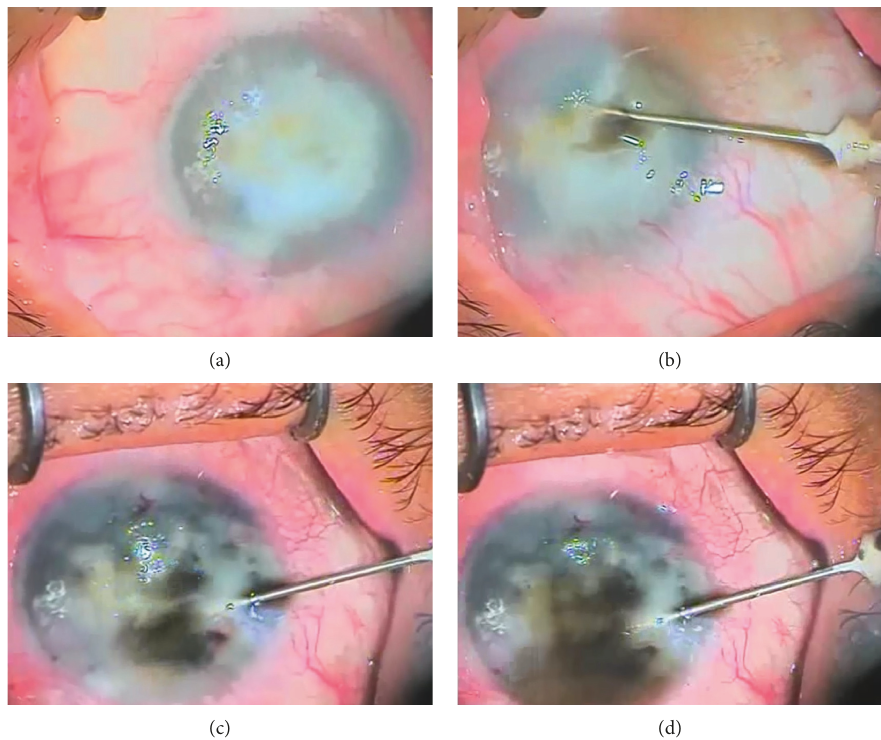
Figure 1: (a) Corneal opacification before tattooing. (b) The bevel of the needle was administered intrastromally tangential to the corneal surface, and injection was started. (c) Repeated multiple sites injections. (d) Full corneal